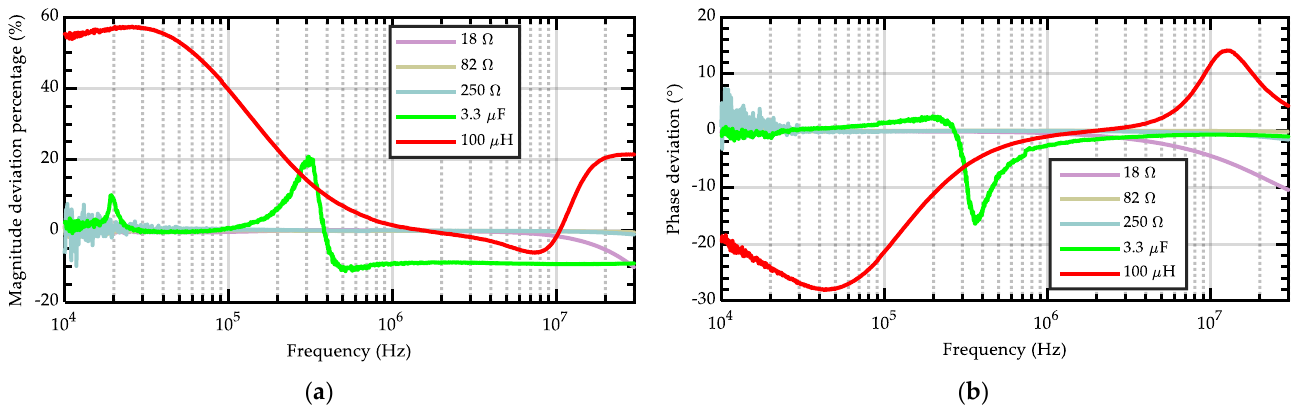
Figure 5. ( a ) Magnitude error (percentage) and ( b ) phase error from the measure of discrete RLC components. Table 1. Maximum magnitude and phase errors from the measure of discrete RLC components.